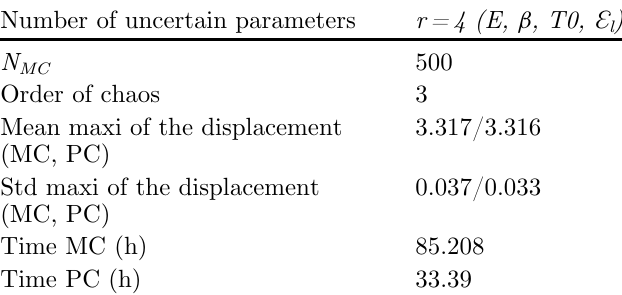
Table 3. Summary results of the